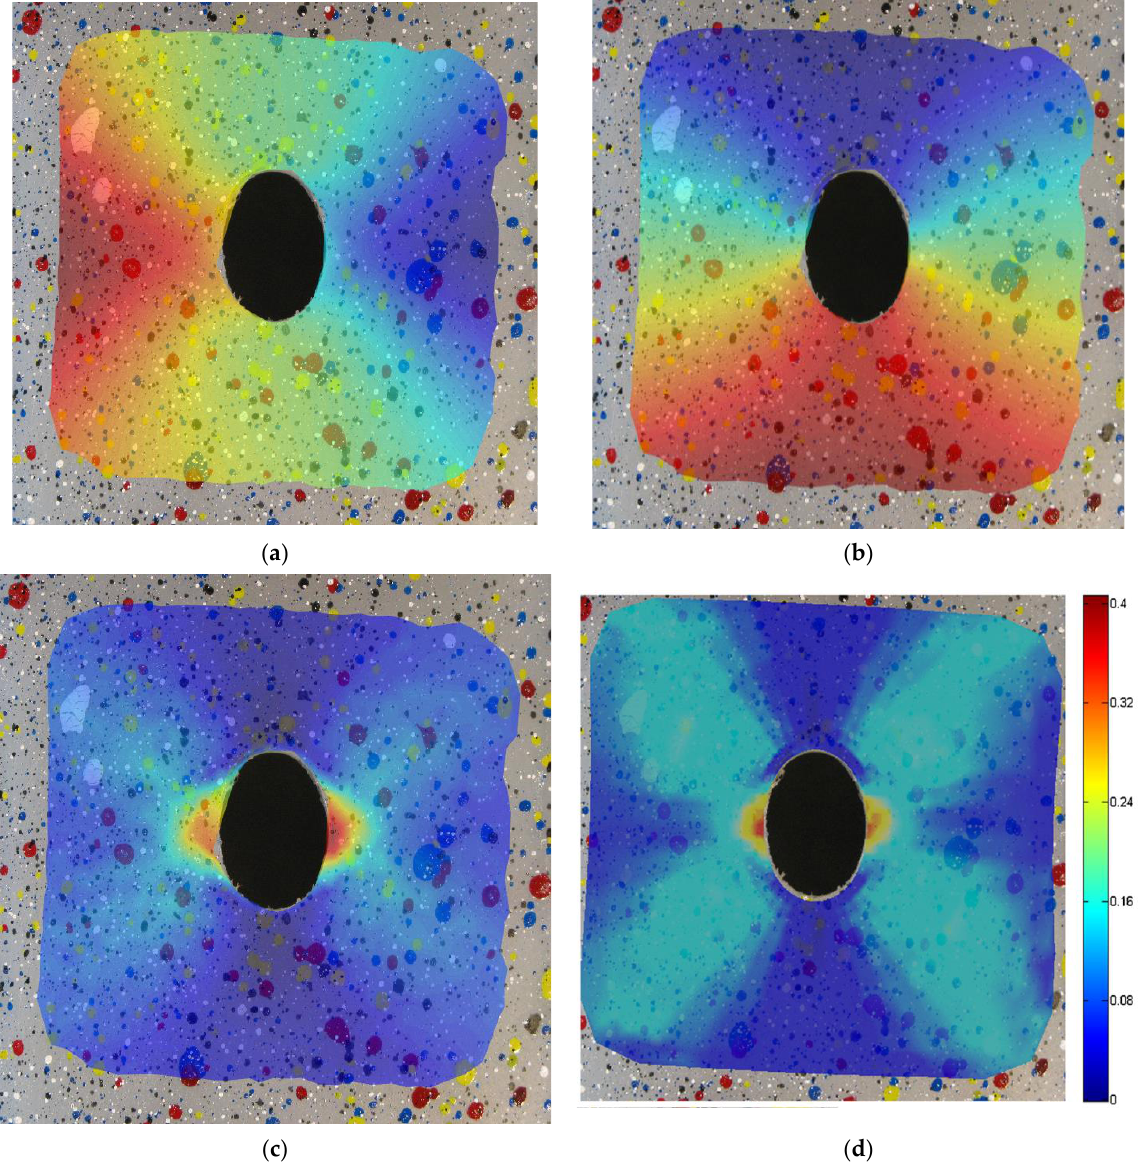
Figure 10. Horizontal ( a ) and vertical displacements ( b ) for the drilled experimental sample under traction. In ( c ) the equivalent strain values retrieved by means of the proposed method are compared with those in the literature ( d ).